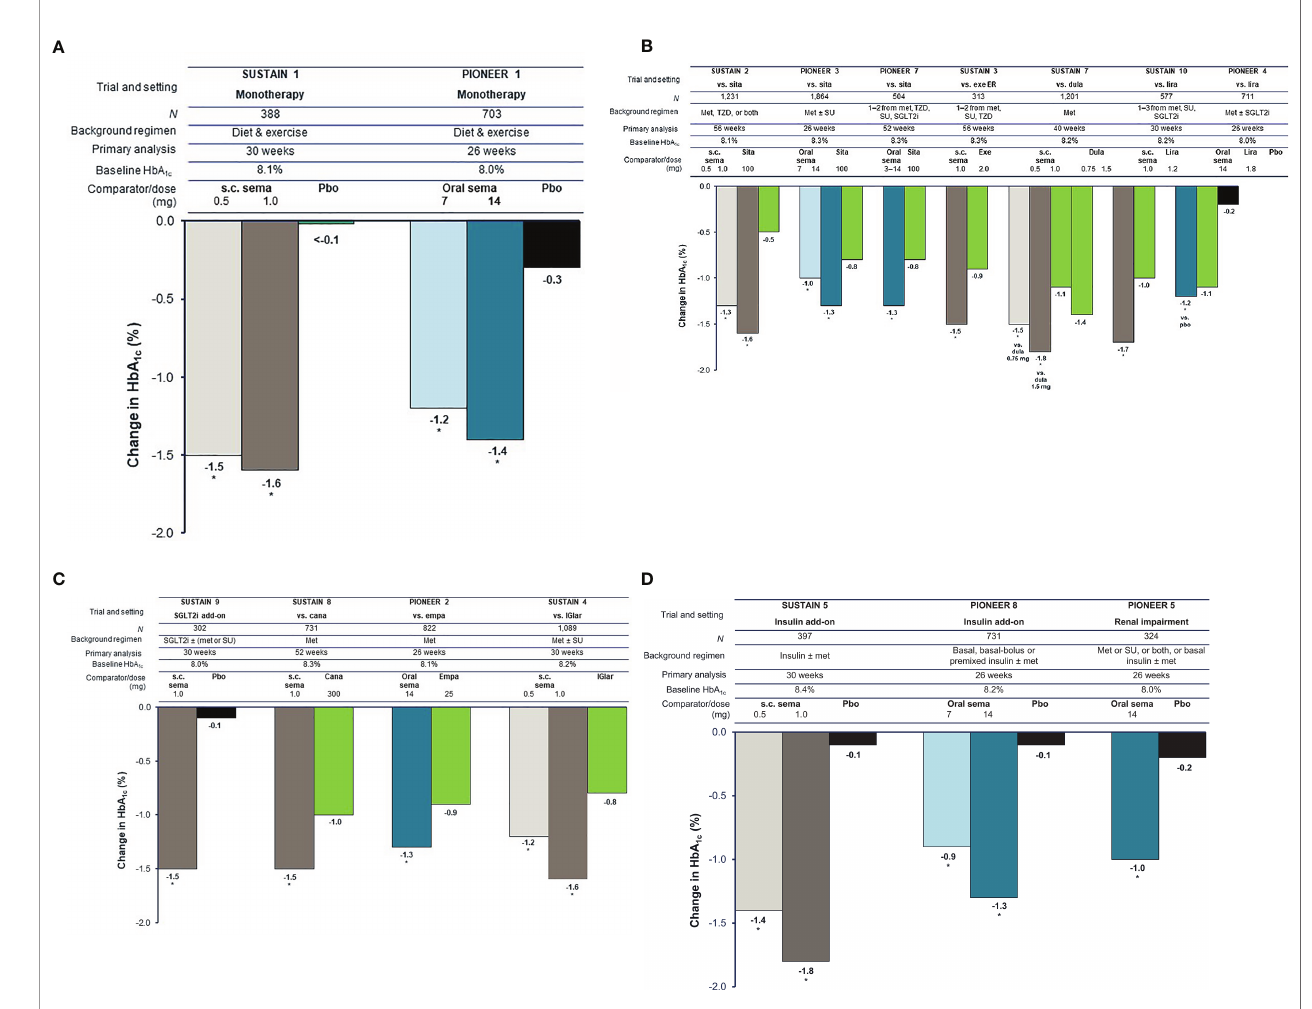
FIGURE 1 | ReductioninHbA 1c withsemaglutideandcomparatorsinglobalglycemicef fi cacytrials(16 – 20, 22 – 26,31, 33). (A) Trials inearlyT2D(meanduration3 – 4years). (B) TrialsinestablishedT2D(meanduration6 – 10years) withincretin-basedtherapies ascomparators. (C) Trials inestablishedT2D(meanduration6 – 10years)withother comparators. (D) TrialsinadvancedT2D(meanduration13 – 15years).For the SUSTAINtrialsshown, HbA 1c reductionatstudyend(weeks30, 40,52,or 56) wastheprimary endpoint. Estimatedmeanchangesfrom baseline inHbA 1c includedonlydataobtainedbeforeinitiationofanyrescuemedicationor beforeprematuretreatmentdiscontinuation. For thePIONEER trials shown,HbA 1c reductionatweek26wastheprimaryendpoint,exceptfor PIONEER7 wheretheprimaryendpointwasachievementofHbA 1c <7.0%(53 mmol/mol) atweek52. Estimatedmeanchangesfrom baselineinHbA 1c areregardless oftrialproductdiscontinuationor rescuemedication(treatmentpolicyestimand). Oral semaglutide3 mgdailywas alsotestedinPIONEER 1, PIONEER3,andPIONEER8; however, thisdoseisnotrecommendedas amaintenancedose[RybelsusSPC] anddata arenotshown(exceptfor inPIONEER7aspartofa fl exibledosingapproachinwhichinvestigatorscouldincreaseordecreasethedoseoforalsemaglutidebetween3,7and14 mgaccordingto ef fi cacyandtolerabilitycriteriaandclinicaljudgment). * p < 0.05for the estimatedtreatmentdifferencewithsemaglutidevs.comparator.Cana, canagli fl ozin; dula, dulaglutide; empa, empagli fl ozin;ER,extendedrelease;exe,exenatide; HbA 1c ,glycatedhemoglobin; IGlar, insulinglargine; lira,liraglutide; met,metformin;N, number of randomizedpatients; pbo,placebo; s.c.,subcutaneous; sema,semaglutide; SGLT2i, sodium-glucoseco-transporter-2inhibitor; sita,sitagliptin;SU, sulfonylurea; T2D, type2 diabetes;TZD,